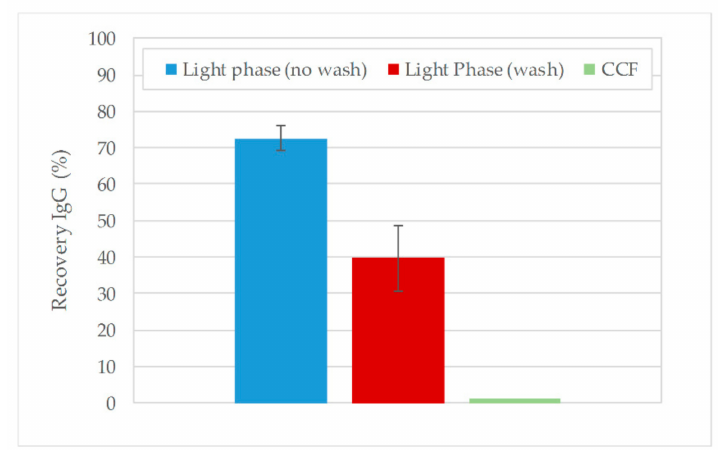
Figure 15. Recovery of mAb after dissolution with varying base materials. Dissolution without a previous washing step resulted in recovery of approximately 72.59% ( ± 3.57%) mAb (blue) recovery from precipitate with subsequent washing resulted in 39.68% ( ± 8.92%) recovery (red). Dissolution of precipitated CCF (cell culture fluid) was not possible (green). Error bars depict the double determination of product recovery.